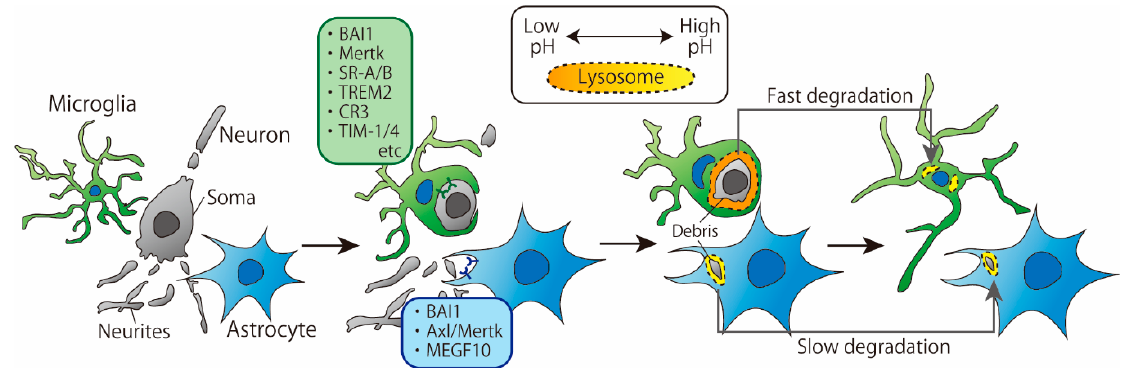
Figure 1. Time course of phagocytosis of cellular debris by microglia and astrocytes. Microglia tend to phagocytose larger cell debris than astrocytes. The pH of microglial lysosome is lower than that of astrocytes, which may result in faster degradation of debris.